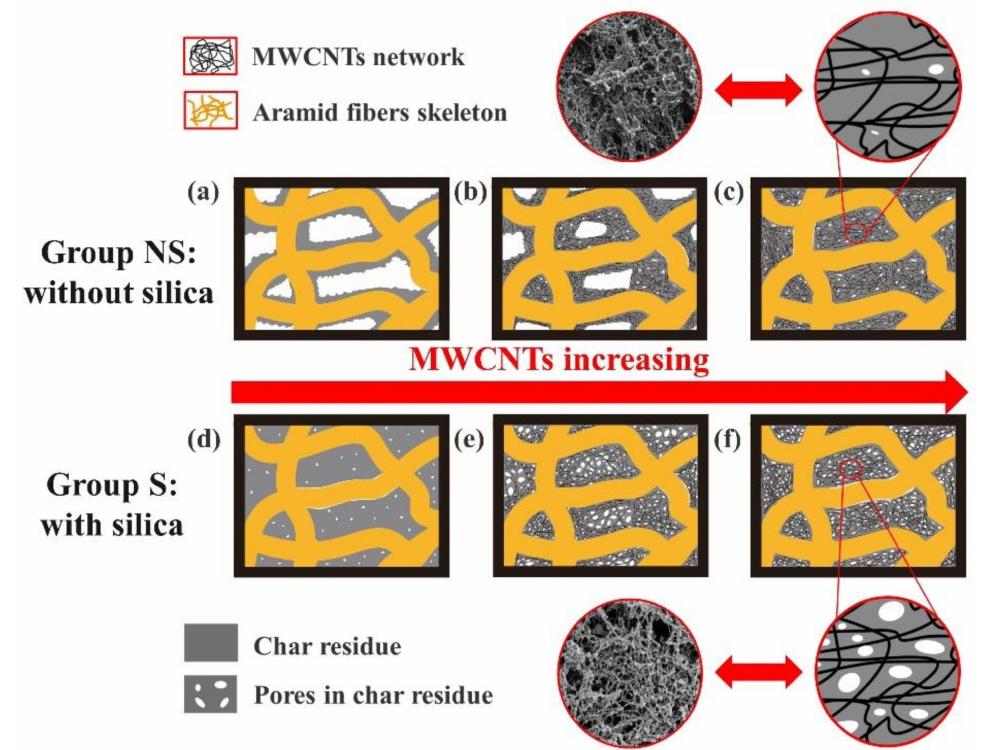
Figure 7. Effects of MWCNTs on char layer structure in EPDM-based insulators with (( a ) without MWCNTs, ( b ) with low content MWCNTs, ( c )) and without silica (( d ) without MWCNTs, ( e ) with low content MWCNTs, ( f